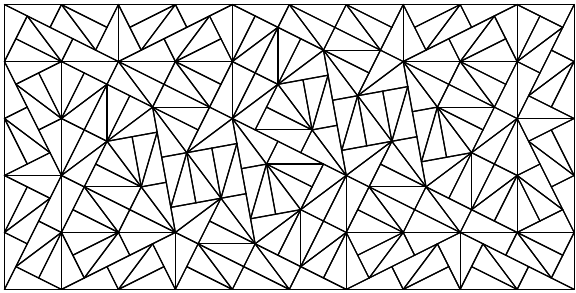
Figure 4. Patch of the pinwheel tiling obtained by three inflation steps from a couple of triangular tiles. It consists of 2 × 5 3 = 250 triangular